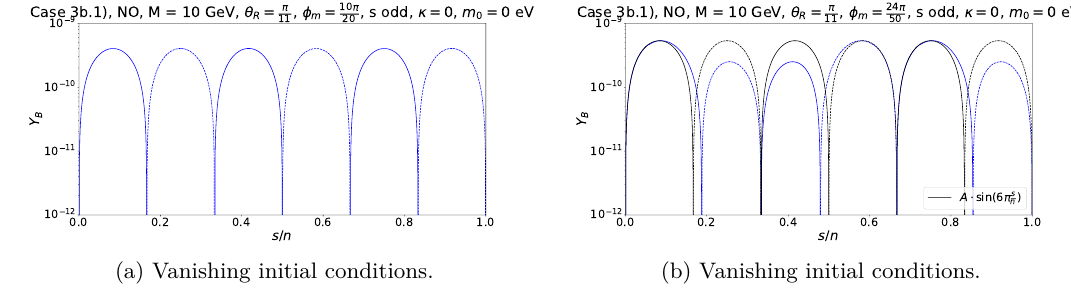
Figure 23 . Case 3 b.1) Y B as function of s/n , treated as continuous parameter, in absence of the splitting κ (and λ ). Light neutrino masses follow strong NO. The Majorana mass M is fixed to . The parameter s is assumed to be odd. The left plot M = 10 GeV and the angle θ R to θ R = π 11 shows the result for n and m being n = 20 and m = 10 and thus φ = 10 π , while the right plot m 20 is for n and m being n = 50 and m = 24 and thus φ = 24 π . In the right plot, we show in black m 50 the function sin 6 φ , which, however, does not agree with the expectations from the CP-violating s combination C , see eq. (6.50). For more details, see text. The coefficient A is given by DEG ,α (cid:3) . Both negative (dashed lines) as well as positive (continuous lines) values of the BAU Max (cid:2) | Y B | are